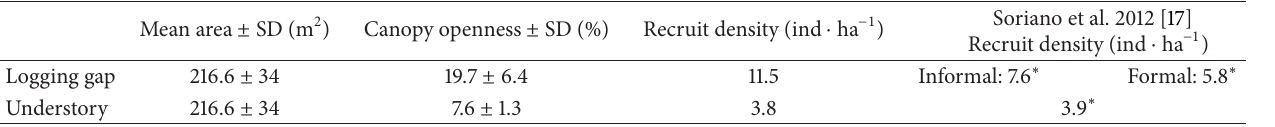
Table3:Meanarea,canopyopenness,andrecruitdensitycomparedbetweenlogginggapandunderstoryenvironments.Additionally,Soriano et al.’s results [17] on recruit density are included. Soriano et al. [17] collected logging gap data for both informal and formal logging types, while all logging gaps in our study were due to informal